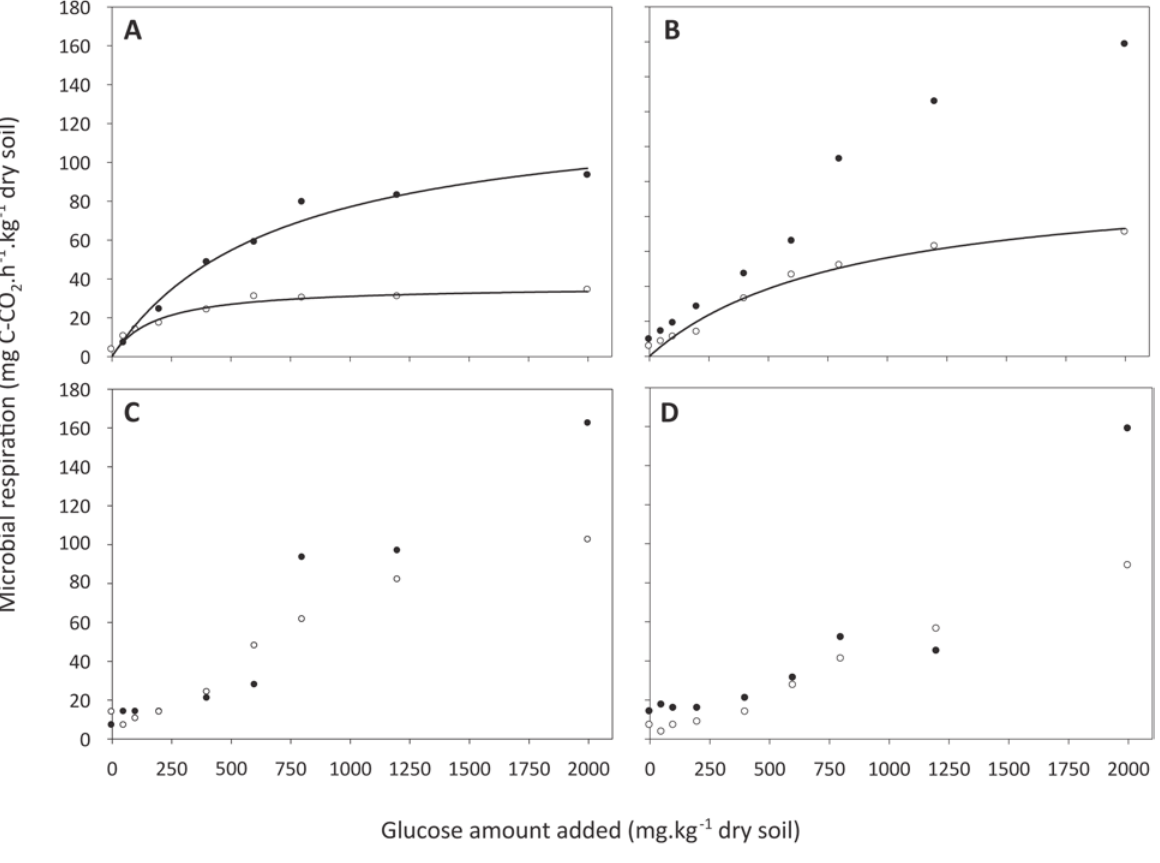
Fig. 1 - Microbial respiration of soils in response to addition of glucose and incubation period under NT (●) and CT ( ○ ) systems. A , 0-12h of incubation. B , 0-24h of incubation. C , 12-24h of incubation. D , 24-48h of incubation. Data represent the mean of four assays under conditions of room temperature. The lines in A and B show the best fit to the Michaelis-Menten equation to a probability level of 5%